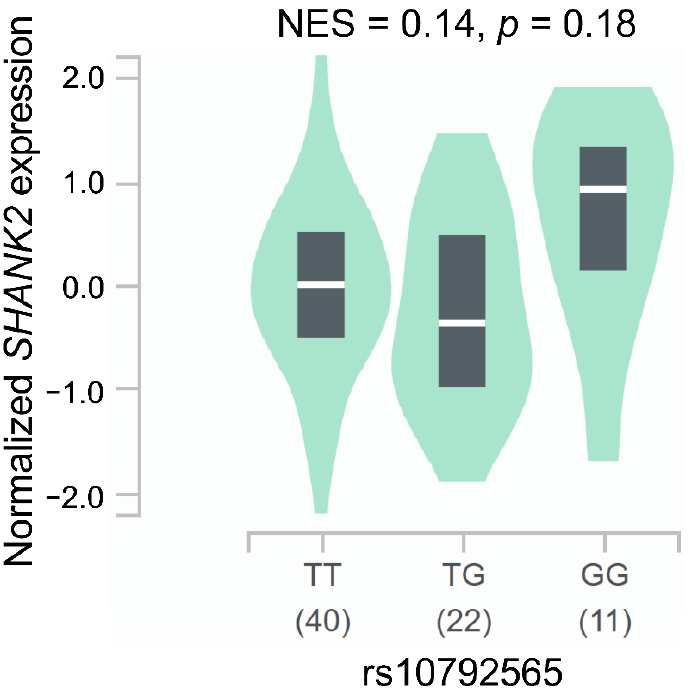
Figure 1. Association of SHANK2 expression levels with the rs10792565 genotypes in normal kidney cortex tissue based on the Genotype Tissue Expression data. Values in brackets represent the number of patients. NES, normalized effect size.